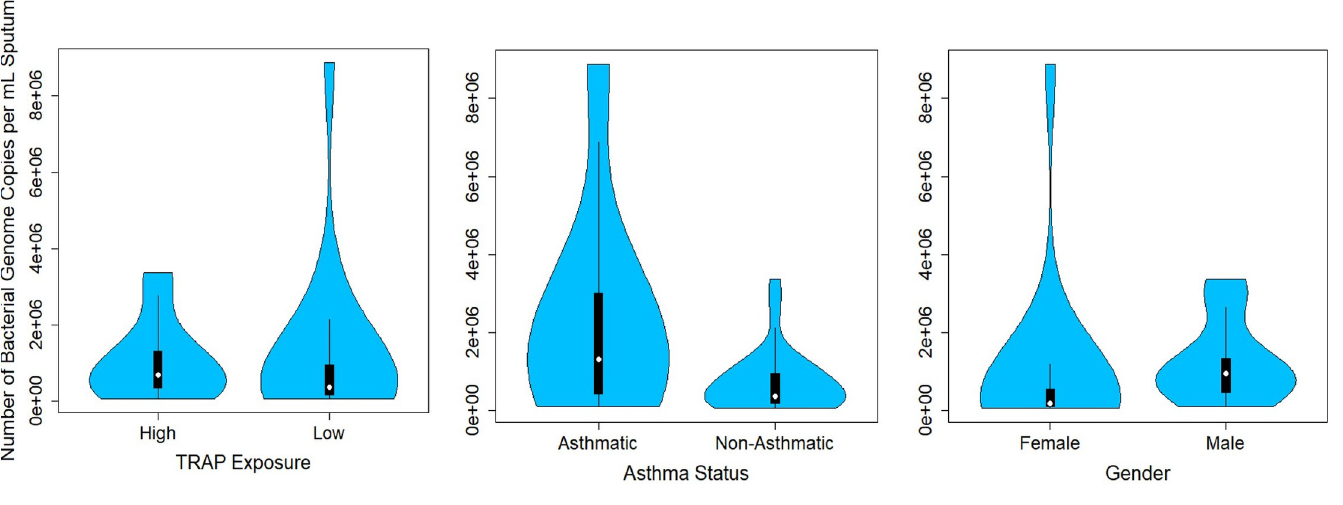
Fig 7. Violin plot comparing the total bacterial load, as measured by qPCR, in the sputum of each TRAP exposure group, each asthma status group, and each gender.